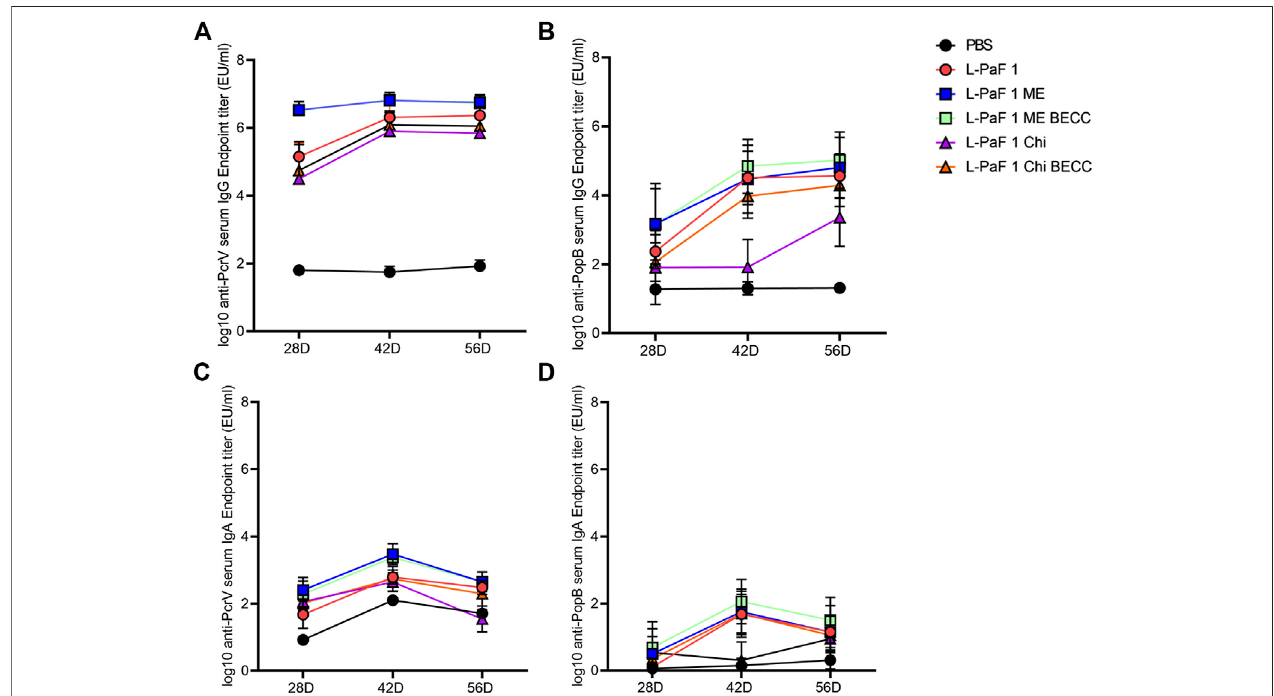
FIGURE3| KineticsofserumIgGandIgA.MicewerevaccinatedINaprime-boostmannerwiththeprimarydoseonday0,followedbytwoboosterdoses14 days apart from each other. Blood samples were assessed for the presence of anti-PcrV IgG (A) , IgA (C) and anti-PopB IgG (B) , IgA (D) by ELISA. Individual titers were represented as EU/ml. Each point represents the mean while error bars represent the SD of each group (n (cid:2) 10 mice/group).